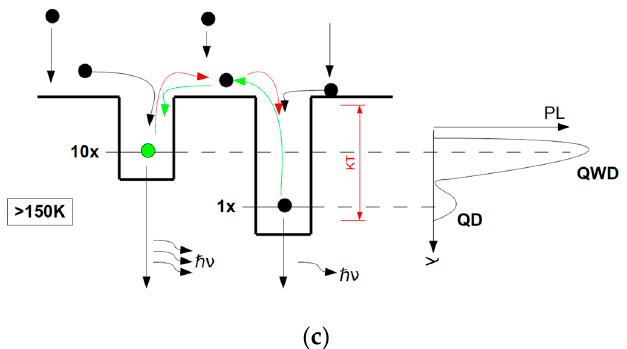
Figure 5. Schematic representation of temperature-dependent evolution of QWD PL spectra: low ( a ), moderate ( b ) , and elevated ( c ) temperatures.